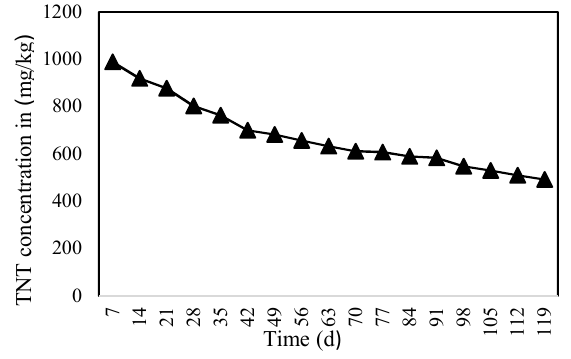
Fig. 1. Disappearance of TNT in presence of sludge in induced aeration (TNT= 1000 mg/kg)